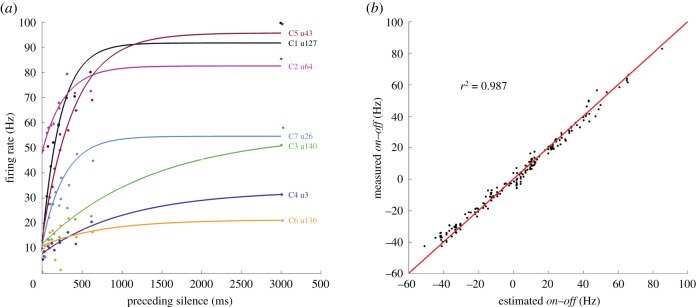
Firing rates estimated from exponential fits closely match measured on–off responses. (a) The average firing rate evoked by noise bursts preceded by varying amounts of silence is used to fit an exponential to each unit. Data and exponential fits for an example unit from each cluster are shown. (b) Scatterplot shows a high correspondence between estimated on–off values based on exponential fits (x-axis) and the real data (y-axis).